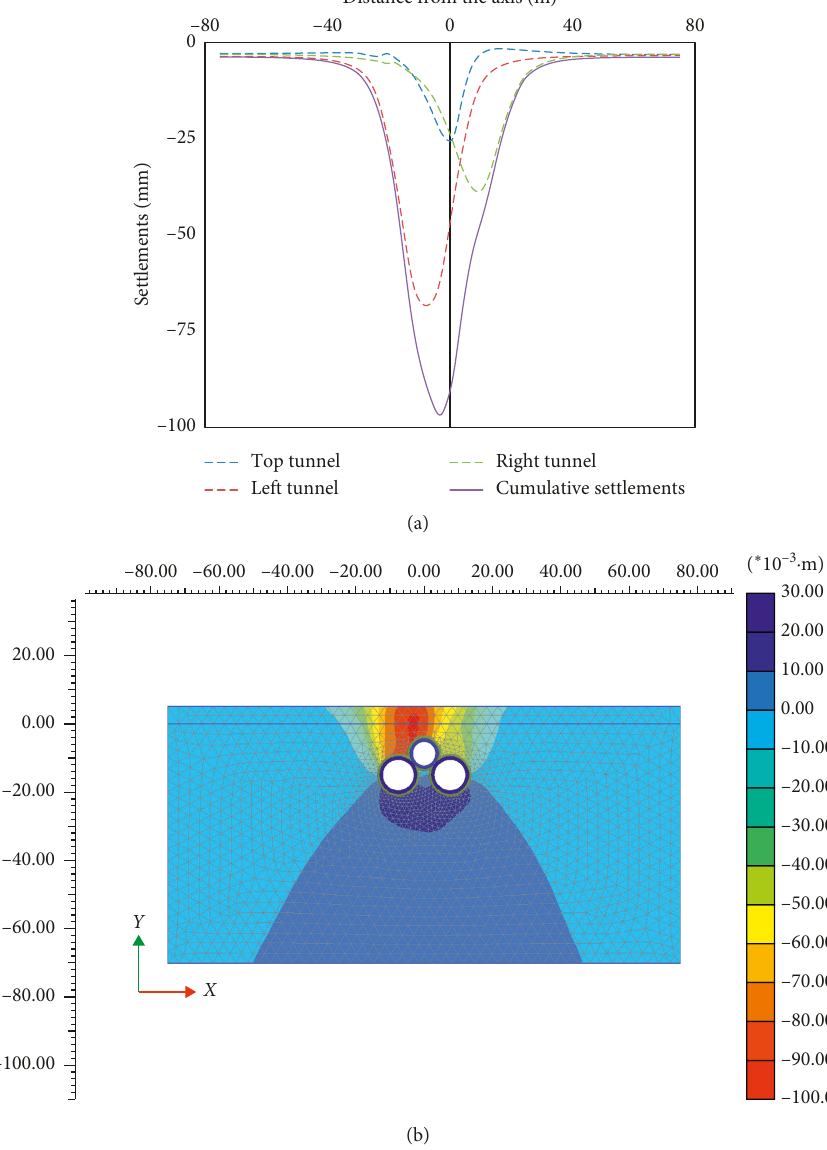
Figure 9: (a) Settlement trough of Left-Top-Right tunnel sequence. (b) Displacement contours resulting from Left-Top-Right